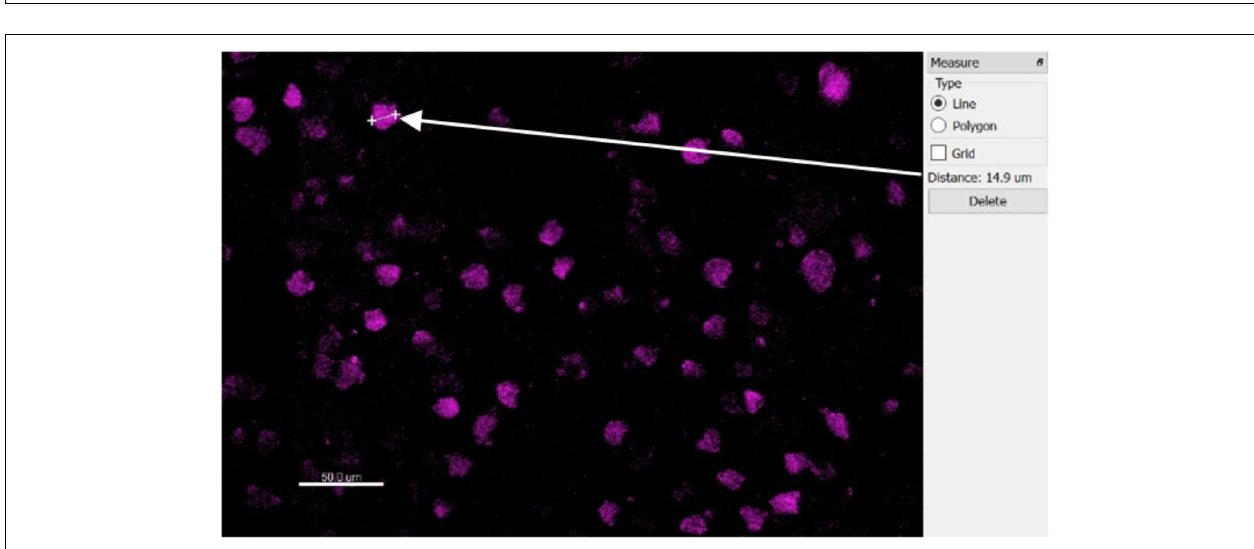
FIGURE 7 | Top-down slice view of NeuN-stained tissue showing one measurement of a typical neuron’s